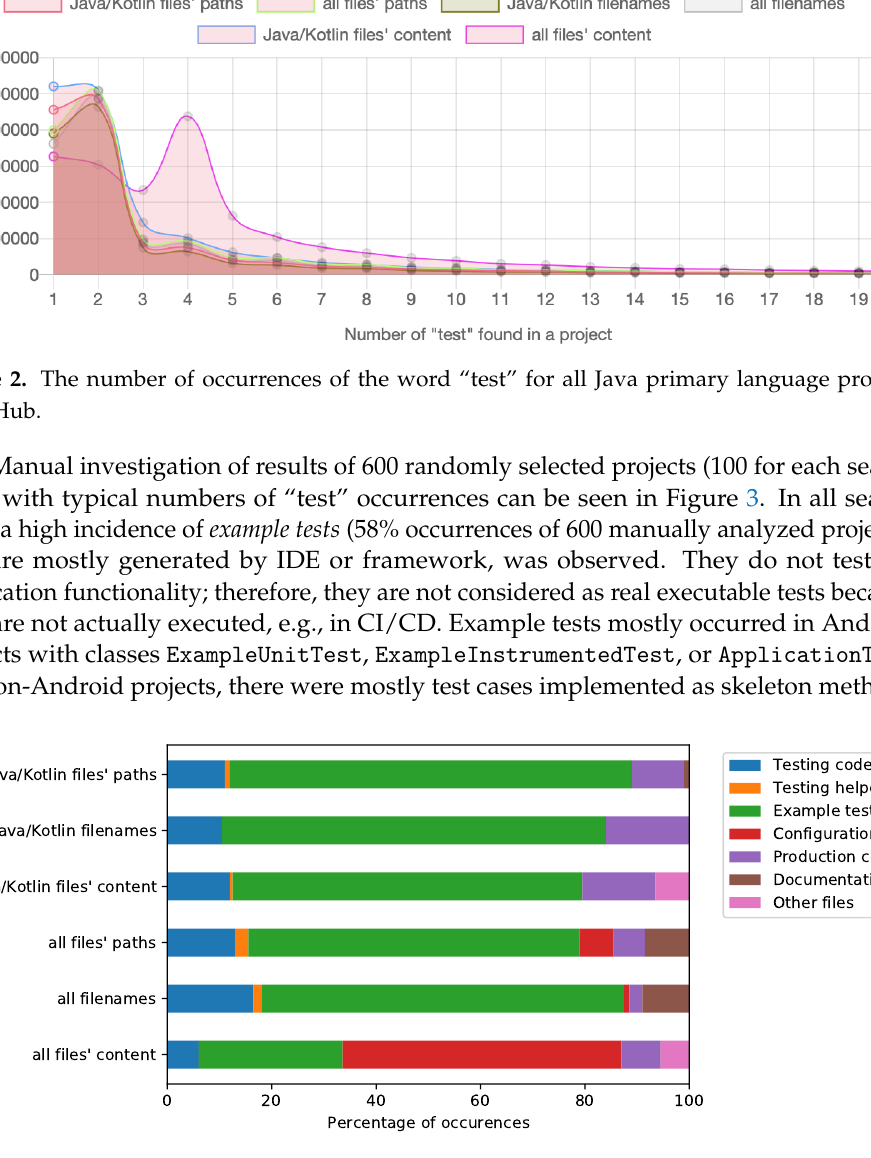
Figure 3. Usage proportion of the word “test” by file type in projects with 4 occurrences for search in all files content and 2 occurrences in other